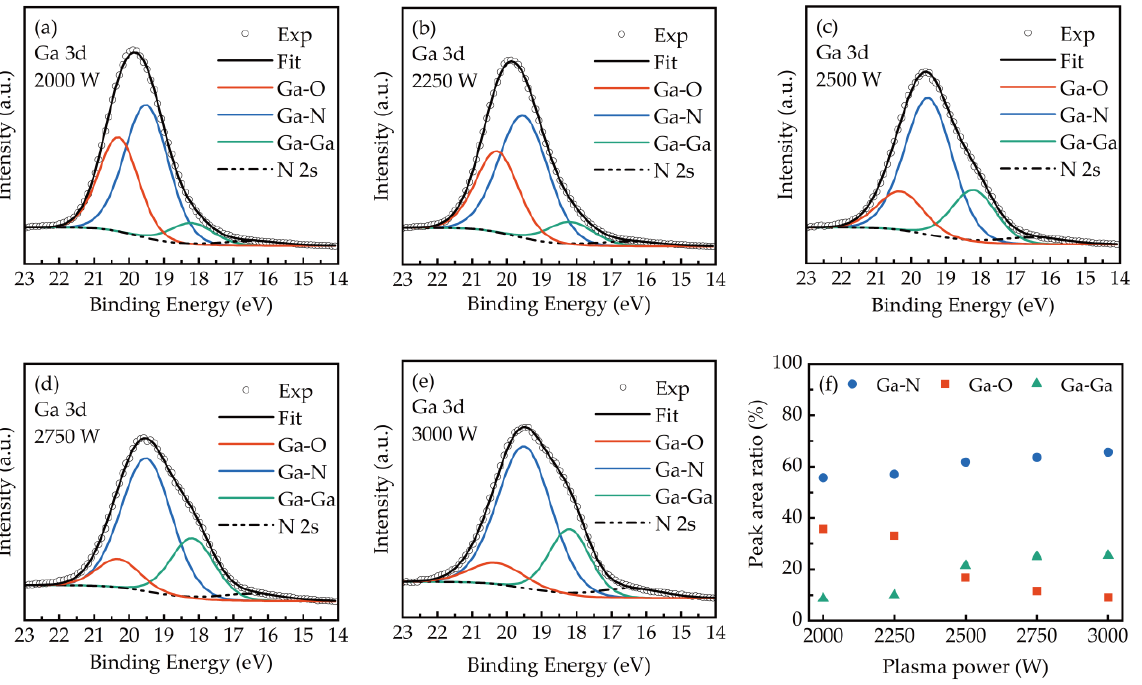
Figure 4. The high-resolution XPS spectra of Ga3d for GaN films obtained at ( a ) 2000 W, ( b ) 2250 W, ( c ) 2500 W, ( d ) 2750 W, and ( e ) 3000 W. ( f ) The bonding percentages of Ga-O, Ga-N, and Ga-Ga bonds in GaN films.